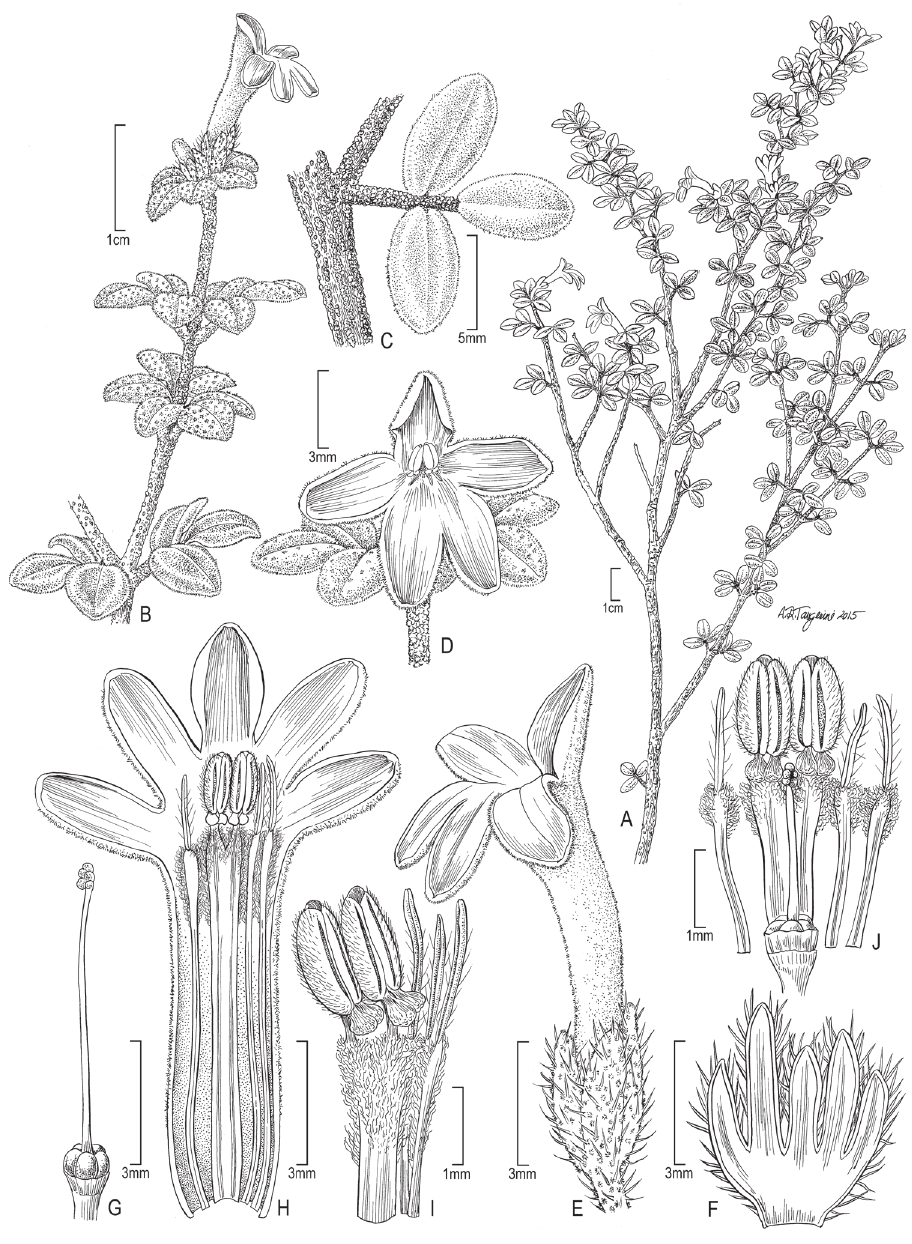
Figure 1. Illustration of Raveniopsis microphyllus . A Habit B Flowering branch C Trifoliate leaf D Flower (face view) E Flower (lateral view) F Calyx with five unequal sepals G Gynoecium H Corolla (split) and androecium I Androecium of bud J Floral dissection of same bud. (Source: Tripp 3191 ,